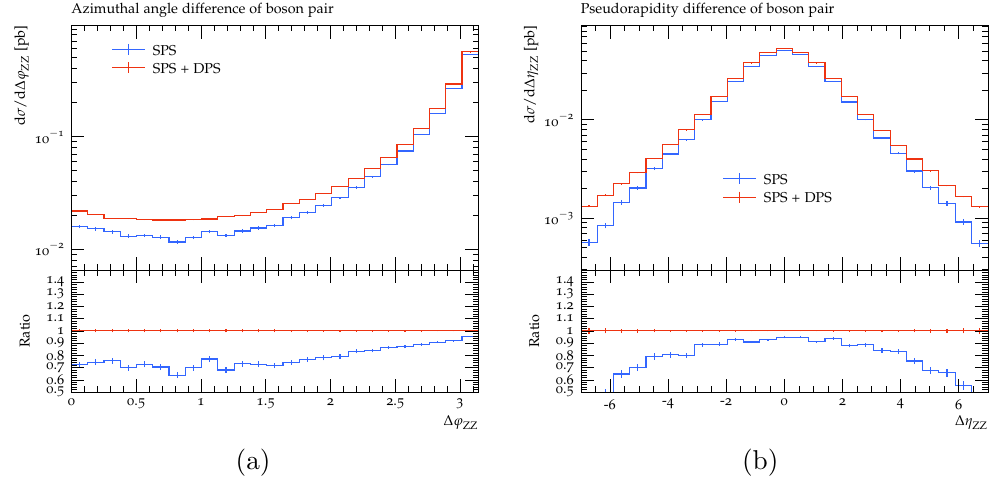
Figure 17 . (a) Di(cid:11)erence of the azimuthal angles of the two Z 0 bosons and (b) di(cid:11)erence of the pseudorapidities of the two Z 0 bosons for the production via SPS only and via SPS combined with DPS. The SPS+DPS setup is the reference in the ratio plots. The histograms are not normalised to